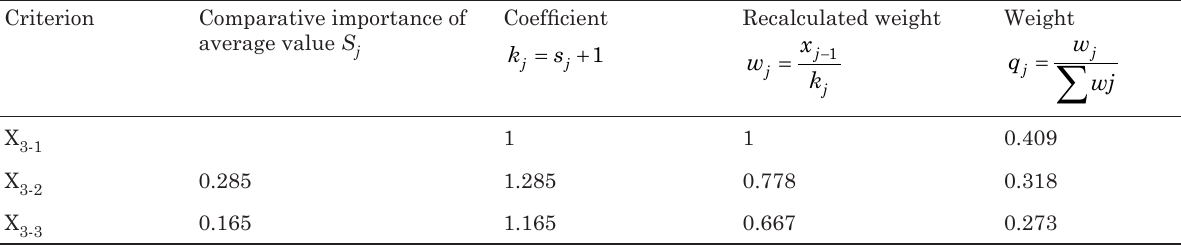
Table 7. Final results of SWARA method in weighting criteria of accessibility